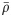
Phase behavior of the linear multivalent systems.(a, b) Phase diagrams for the An+Bn and An-Bn systems, respectively. The purple line is a 2-dimensional linear interpolation for ρ¯ = 0.025, and the area encapsulated by the purple line are where the systems have large density inhomogeneities and are thus considered to be phase separated. The green line is a 2-dimensional linear interpolation for ϕc = 0.5 and thus is the proxy for the percolation line. (c, d) ρ¯ and ϕc curves as a function of concentrations at T* = 0.383 (solid lines in (a) and (b)). (e) Width of the two-phase regime, w(T*), as a function of the reduced temperature. Not only does the An-Bn system have a higher critical temperature (T* ~ 0.6 vs. T* ~ 0.4), but also has a wider two-phase regime than the An+Bn system.